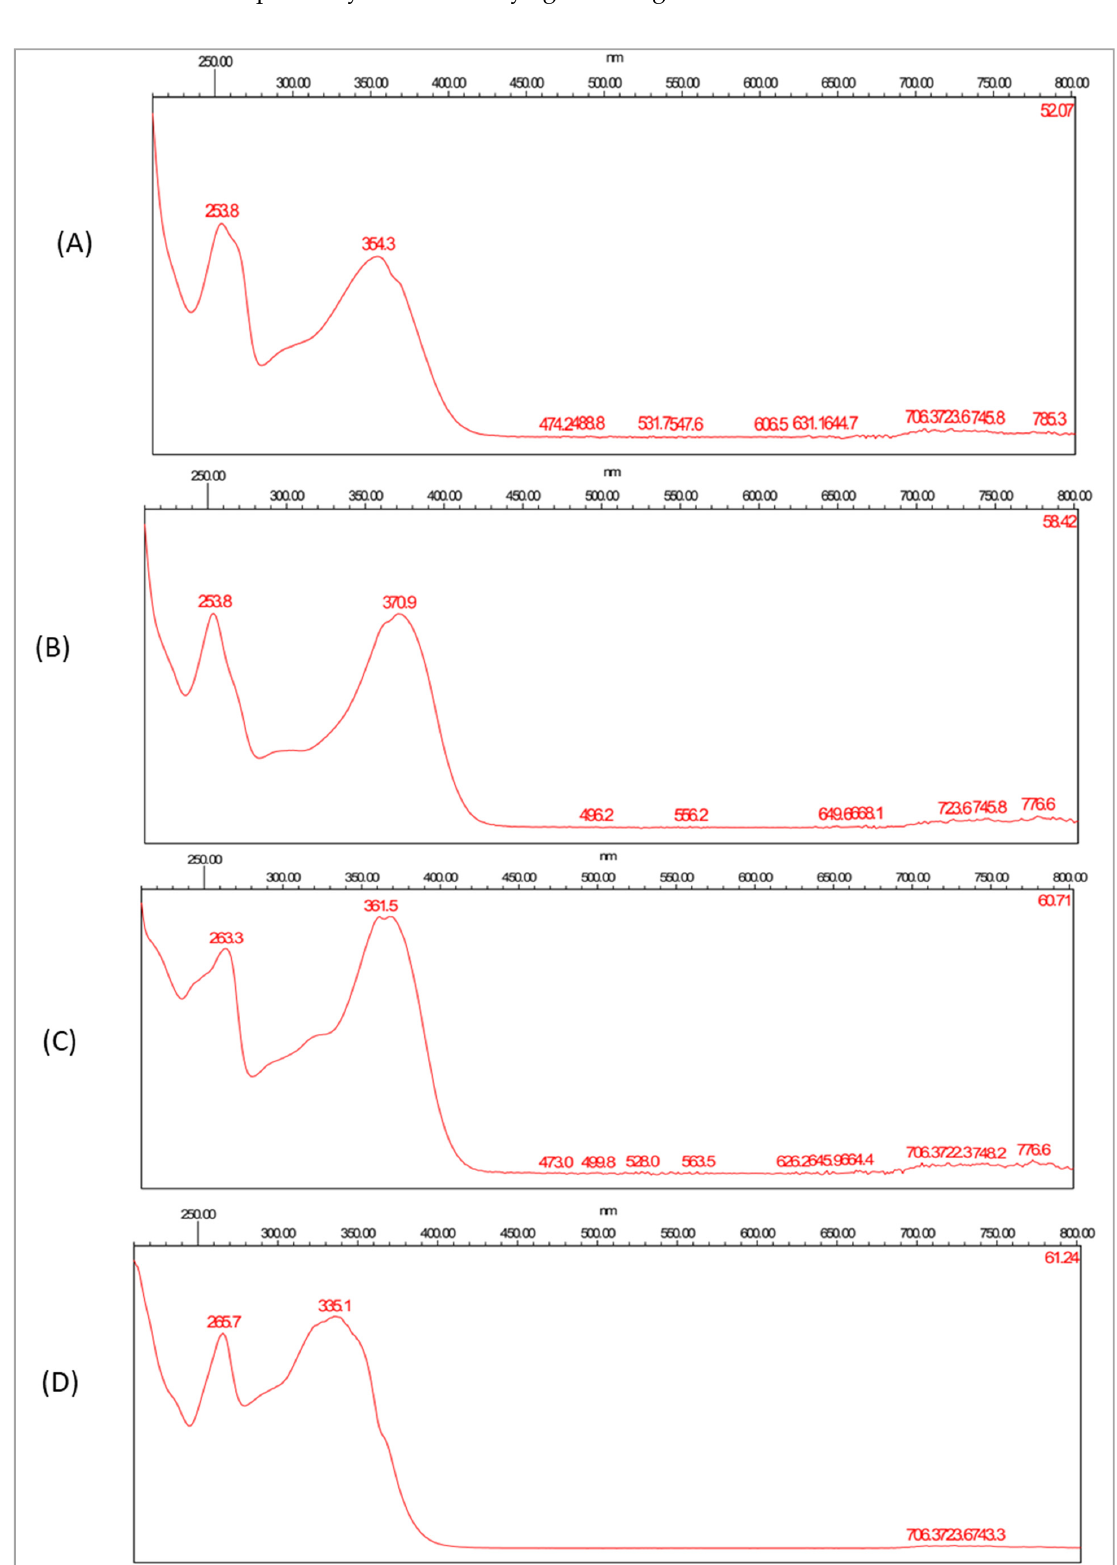
Figure 8. UV–vis absorbing spectrograms of rutin ( A ), quercetin ( B ), kaempferol ( C ), and apigenin ( D ).